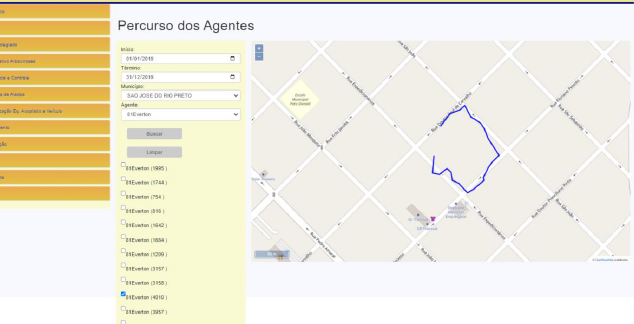
Figure 6 . Example of route made by a field agent on a block (blue line). Note: On the left: Menu of activities: Cadastro = Register; ADL = Larval Density Evaluation; ADL Colegiado = Larva Density